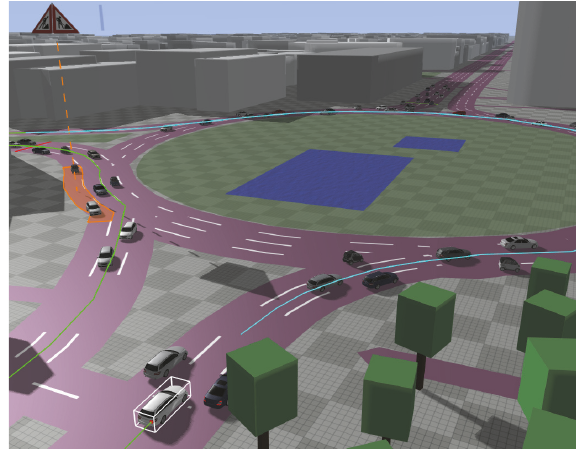
Figure 10: Simulator reference implementation, example scenario: construction site at round about, Ernst-Reuter-Platz, Berlin, Ger-